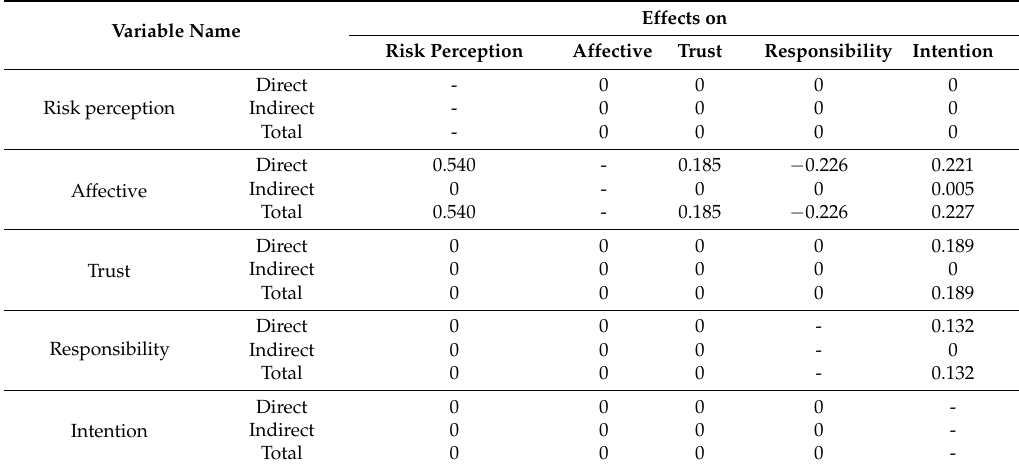
Table 7. The direct, indirect, and total effects of